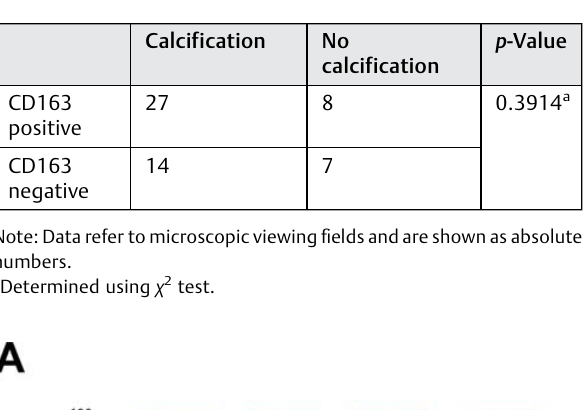
Fig. 6 Colocalization of hemoglobin with the hemoglobin receptor CD163 in human vascular and valvular tissue specimens. ( A ) Representative examples of fi ndings in the aortic valve, carotid artery and aortic aneurysm are shown; 1,000-fold magni fi cation. ( B ) Results of the quantitative analysis of hemoglobin-positive areas and their colocalization with CD163 immunosignals. Results are expressed as percentage (%) of the total number of viewing fi elds. Table 6 Detection of CD163 in areas with and without Table 7 Presence of hemoglobin and CD163 calci fi cation calci fi cation in all types of vascular lesions